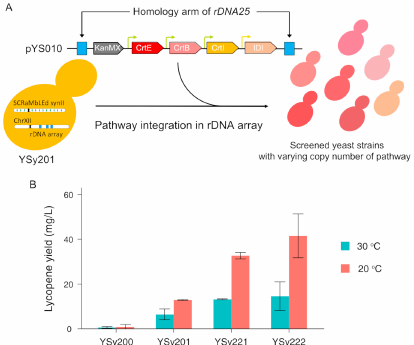
Figure 3. Characterization and improvement of lycopene -producing strain with optimized path- way. ( A ). Schematic illustration of host optimization by rDNA integration for improving lycopene production in S. cerevisiae . ( B ). Lycopene quantification of SCRaMbLEd strains and their variants, in comparison with the initial unSCRaMbLE strain YSy200. Error bars indicate ± SD (n = 3). Comparing with the initial strain YSy200, the combined efforts of pathway and host strain optimization result in a maximal 129.5-fold improvement in the lycopene